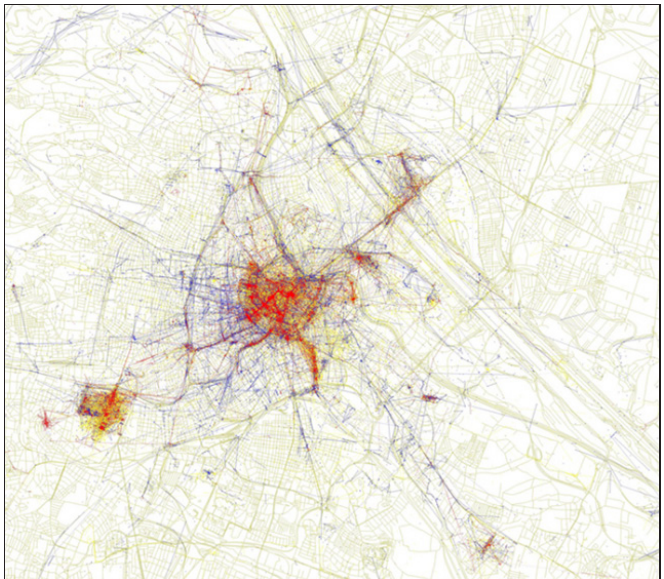
Figure 2: Screenshot of Vienna from the Flickr Album Locals and Tourists. In red, photos uploaded by tourists, in blue those uploaded by locals, in yellow those not assignable; CC BY-SA 2.0 Eric Fischer, Flickr.